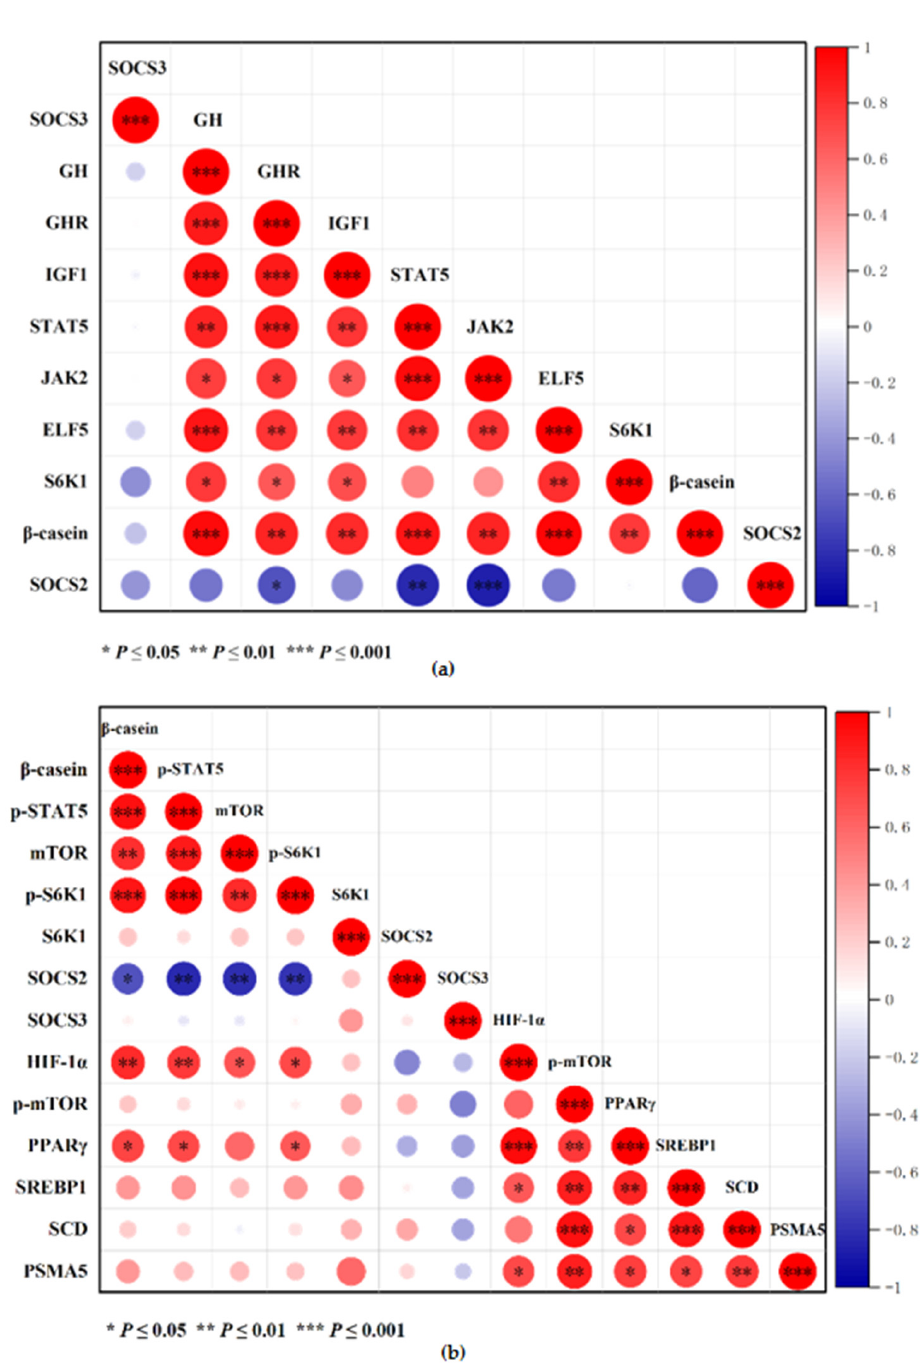
Figure 7. Correlation and thermographic analysis of mRNA and protein expression. ( a ) Correlation heat map of gene expression. Blue indicates a negative correlation, and red indicates a positive correlation; the circles’ size and color show the correlations between the genes. ( b ) Correlation heat map of protein expression. Symbols *, **, and *** indicate significant correlations between genes or proteins at p ≤ 0.05, p ≤ 0.01, and p ≤ 0.001, respectively.